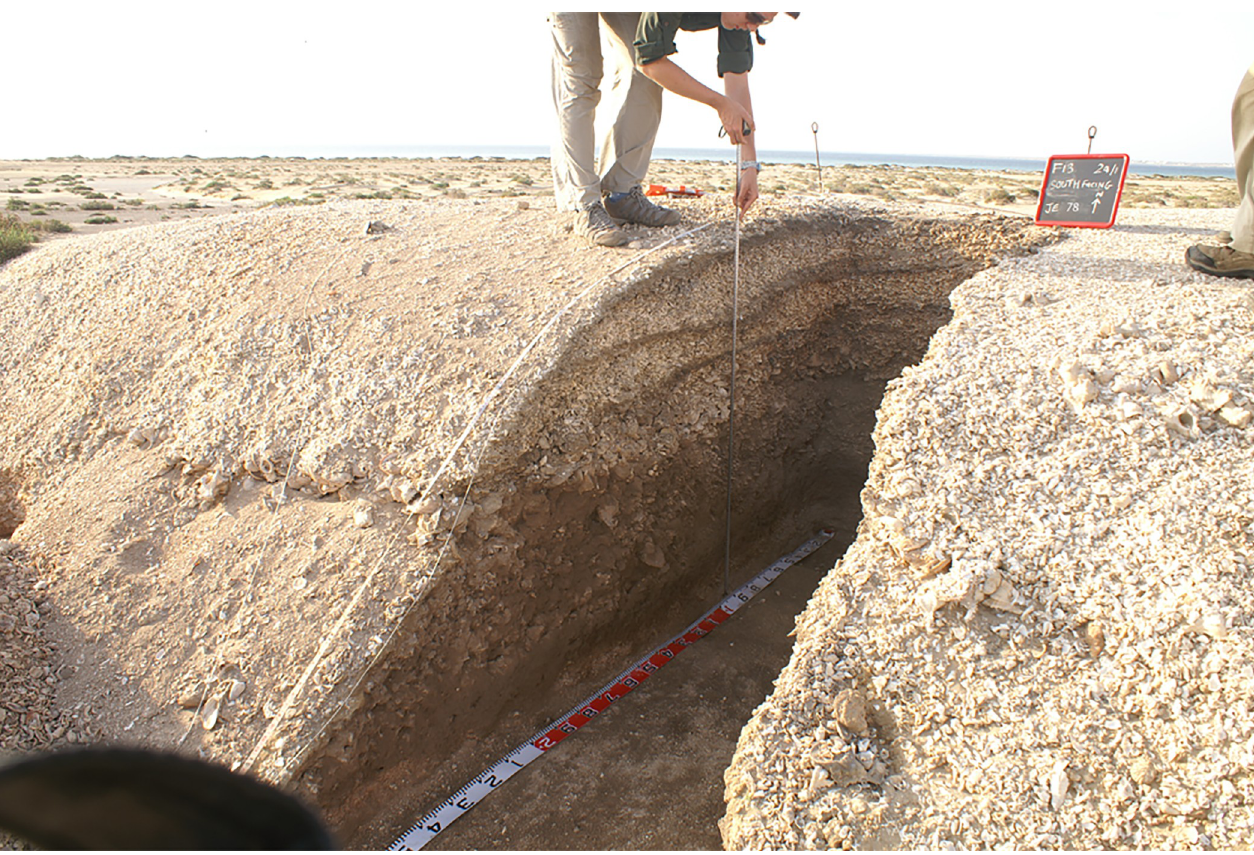
Fig 8. Mound JE0078 on the main shoreline of the Janaba East cluster (Transect 3) after excavation, showing ash lenses clearly visible in section. The white shell matrix in the upper deposit is dominated by shells of C . fasciatus , the darker shell matrix in the lower layers has a higher proportion of the large gastropod, Chicoreus ramosus . Photo by Geoff Bailey, January